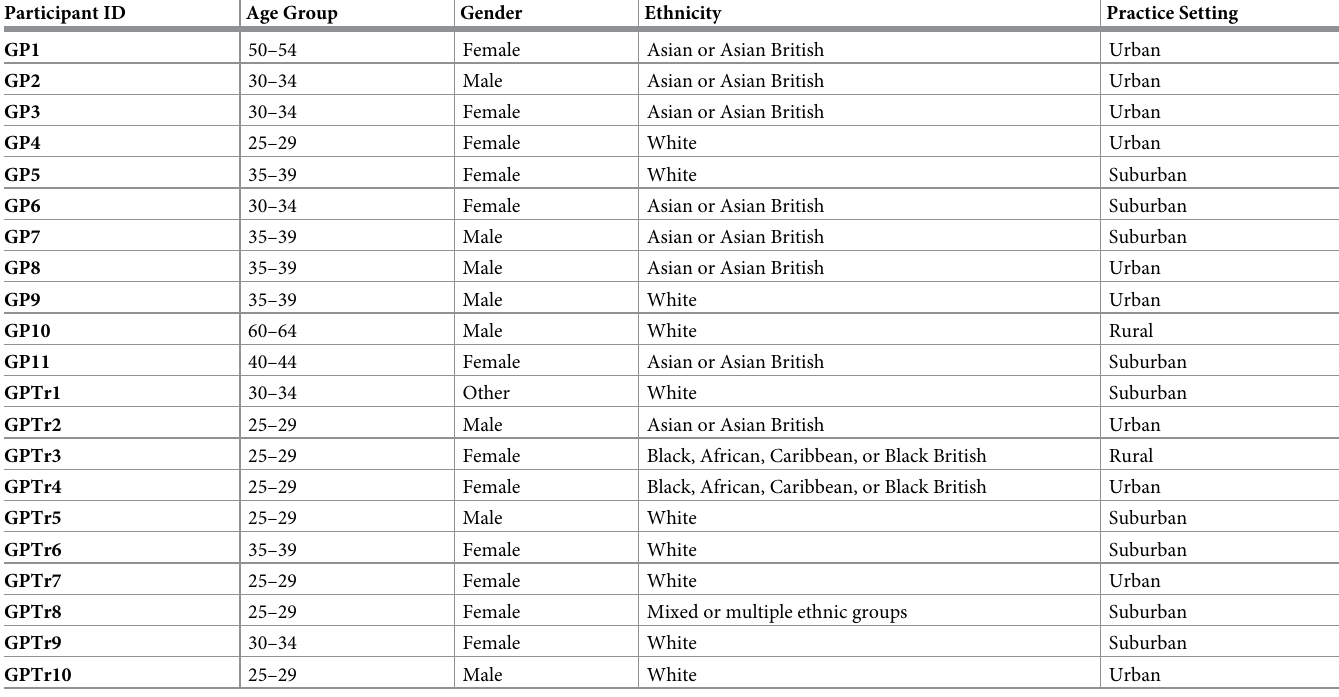
Table 3. A description of each participant’s (N = 21) demographic and practice